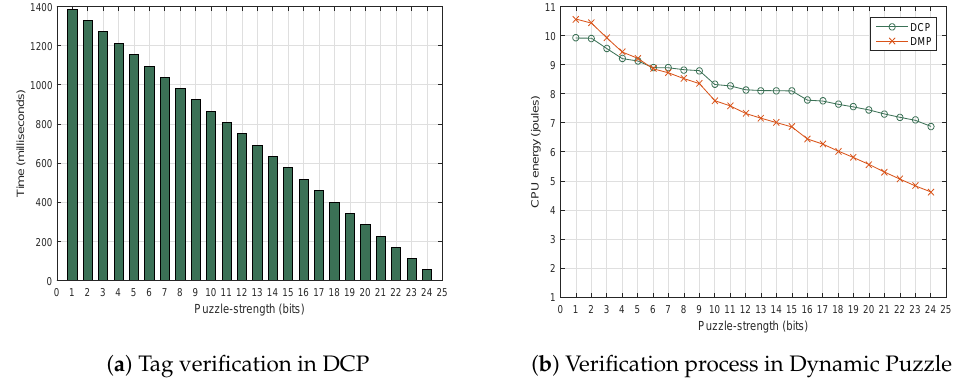
Figure 15. The resources of Dynamic Puzzle verification in